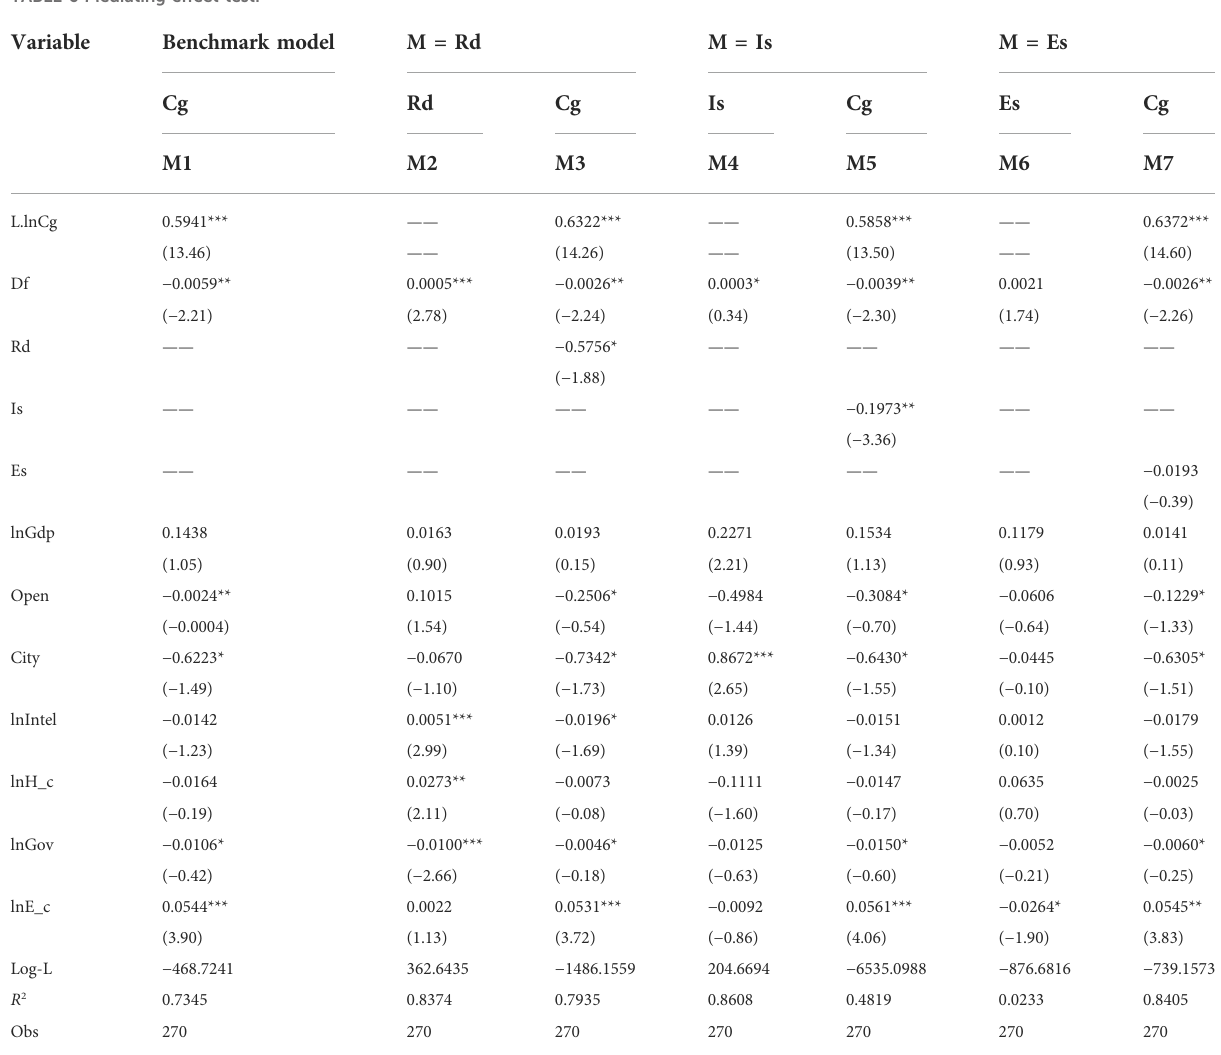
TABLE 6 Mediating effect